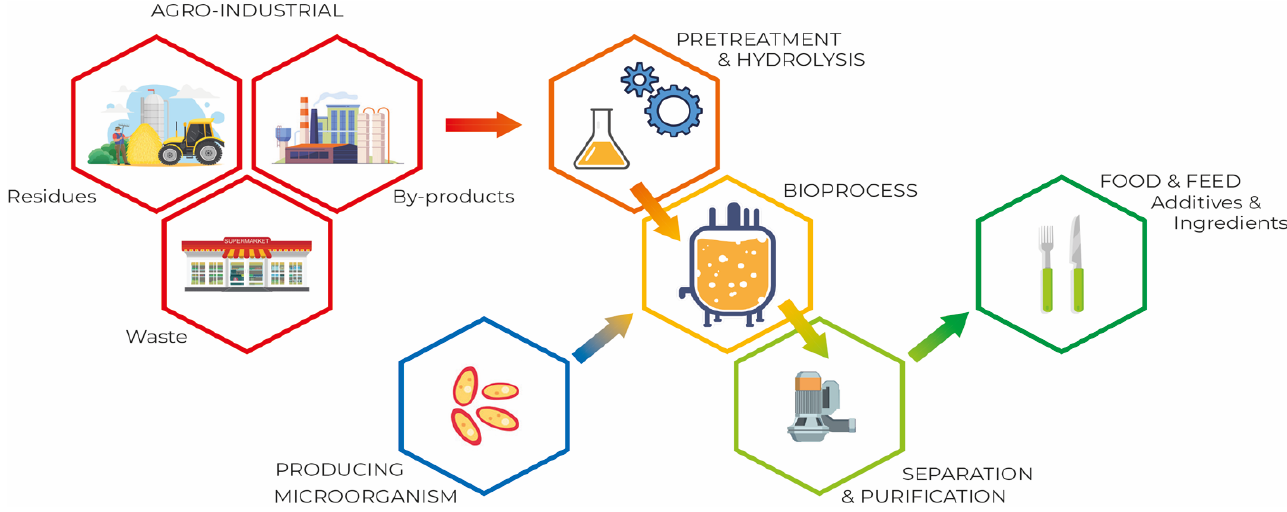
Figure 2. Microbial protein production process.